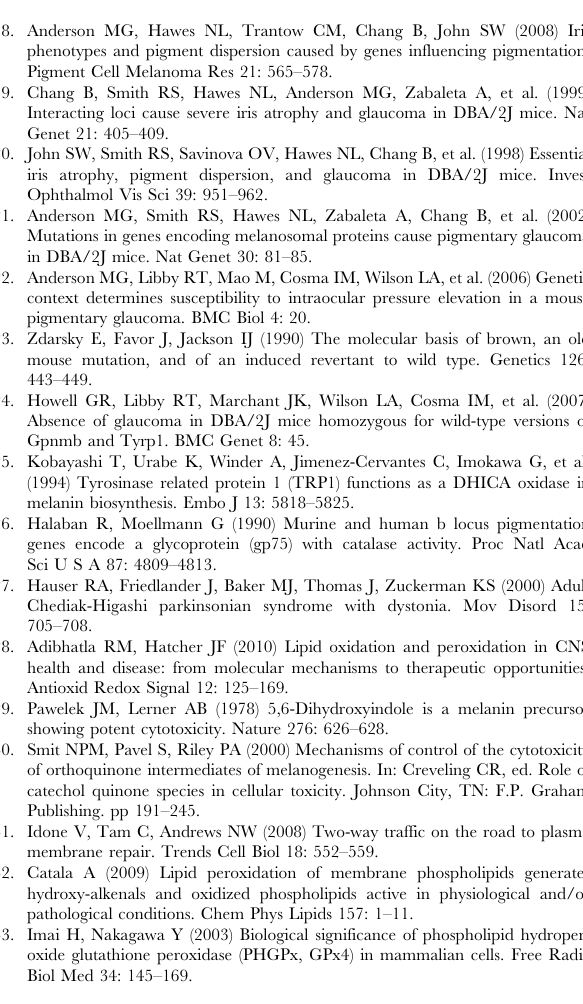
Figure S5 Lyst mutation leads to increased levels of 4-HNE labeling and lipid hydroperoxide. 4-HNE labeling of C57BL/6J ( left column ) and B6- Lyst bg-J ( right column ) eyes. Identical cryosections imaged with phase-contrast ( top row ) or epifluorescence ( bottom row ) microscopy. (A, C) C57BL/6J irides have modest 4-HNE labeling of the iris stroma ( arrows ). (B, D) B6- Lyst bg-J irides have increased levels of 4-HNE labeling of the iris stroma ( arrows ), as well as pigment engulfed macrophages ( arrowhead ). All other labeling is non-specific, as determined by a negative control in which no primary antibody was used. Figure S6 D2. Lyst bg-J mice exhibit no spinal cord or sciatic nerve degeneration. (A, B) Cross sections of the thoracic spinal cord stained with H&E. Images of the ventral grey matter illustrate similar numbers of motor neurons ( arrows ), indicating no nerve degeneration in D2. Lyst bg-J compared to B6- Lyst bg-J age-matched controls ( n = 5 for each strain). (C, D) Cross sections of sciatic nerves stained with toluidine blue reveal a similar density of myelinated axons with no overt degeneration in D2. Lyst bg-J compared to B6- Lyst bg-J age-matched controls ( n =5 for each strain). Scale bars = 10 m m. All mice =17–20 months of age. Figure S7 Lyst and Tyrp1 are expressed in the mouse brain.